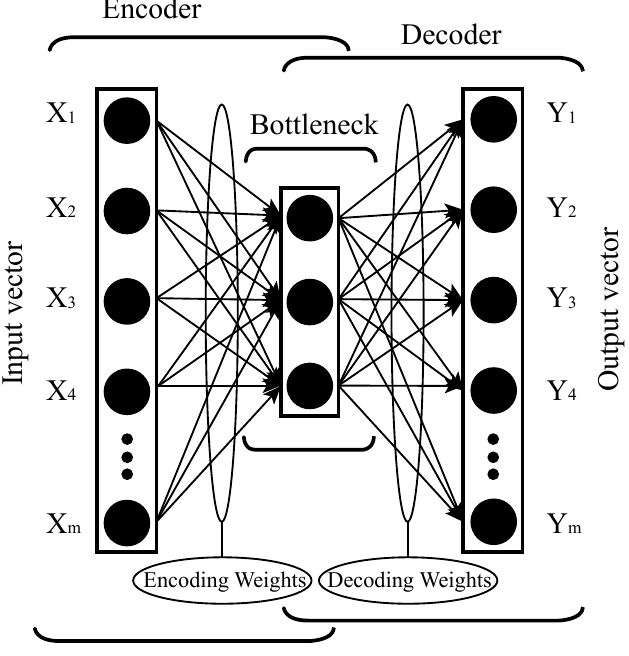
Figure 1. Architecture of the